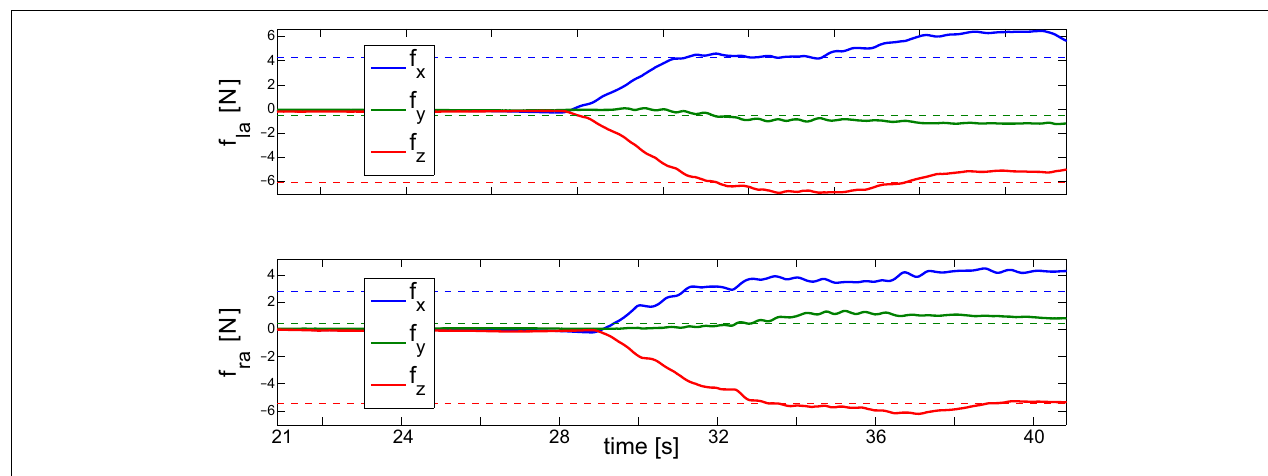
FIGURE 9 | Results of the double-support experiment on four non-coplanar contacts (both feet and arms) .The plots represent the evolution of the contact forces at the left (top) and right (bottom) arms when contact is established.